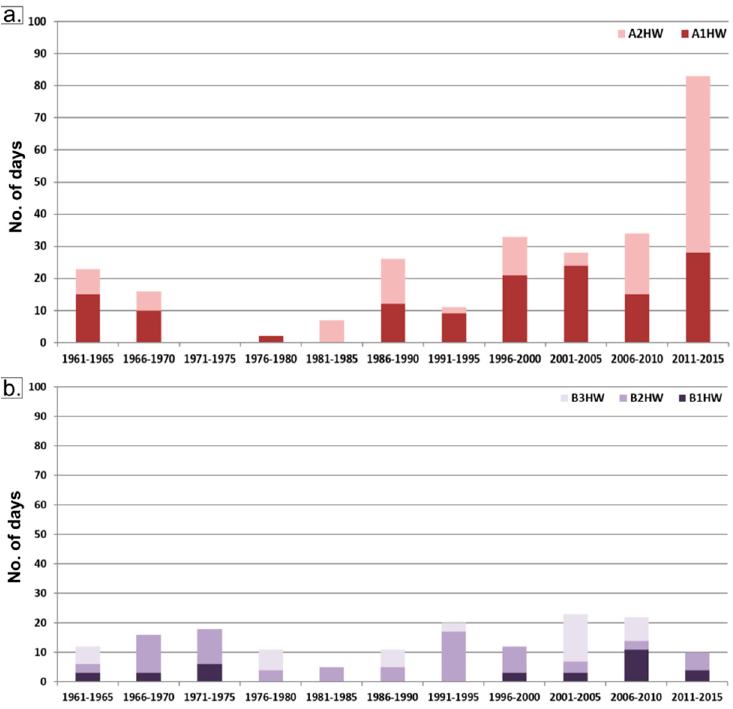
Figure 7. Five-year frequency of HWs/WSs days in Romania (1961–2015) during: ( a ) radiative sub-types; and ( b ) advective sub-types.